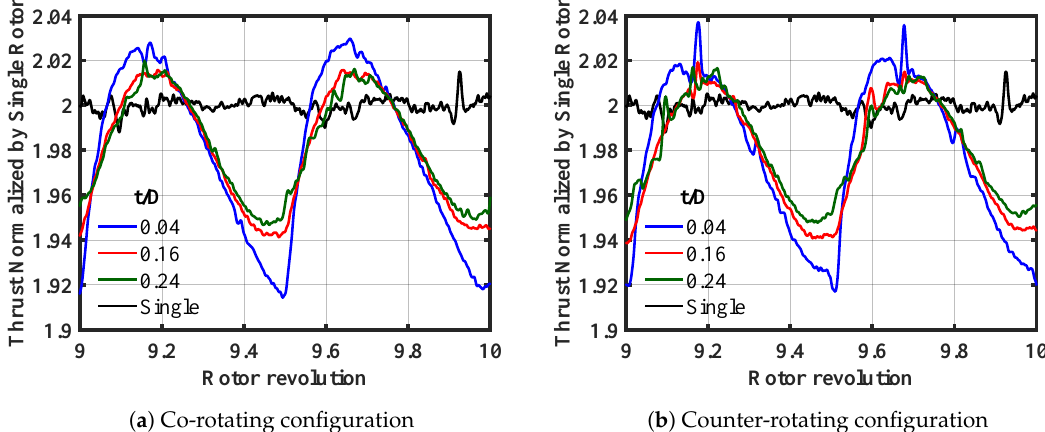
Figure 10. Computed time-varying thrust using Helios of the dual rotor systems operating at 6000 RPM normalized by the mean thrust value of the single rotor. The thrust signal of the single rotor was doubled and plotted in black for